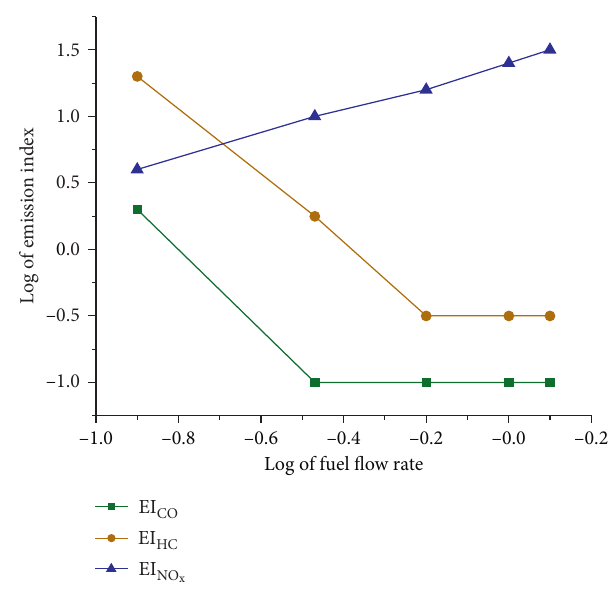
Figure 6: Logarithmic regression relationship between fuel flow rate and emission